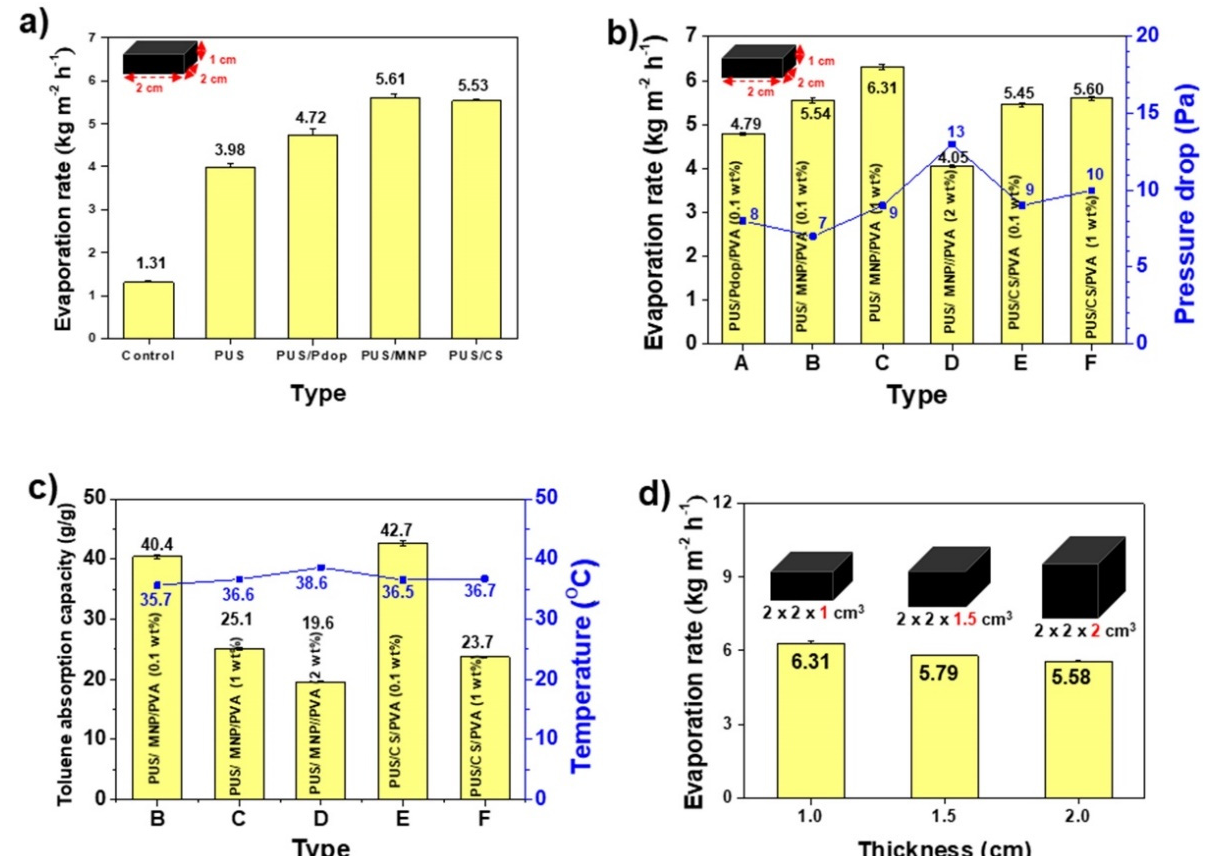
Figure 3. ( a ) Toluene evaporation rates for rectangular structures made of PUS, PUS/Pdop, PUS/MNP, and PUS/CS before coating PVA. ( b ) Toluene evaporation rates and pressure drops for the abovementioned samples after coating PVA with 0.1–2 wt%. ( c ) Toluene absorption capacity and temperature of rectangular structures made of PUS/MNP/PVA (0.1–2 wt%) and PUS/CS/PVA (0.1–1 wt%). ( d ) Toluene evaporation rates of rectangular structures made of PUS/MNP/PVA (1 wt%) with different thicknesses of 1–2 cm.